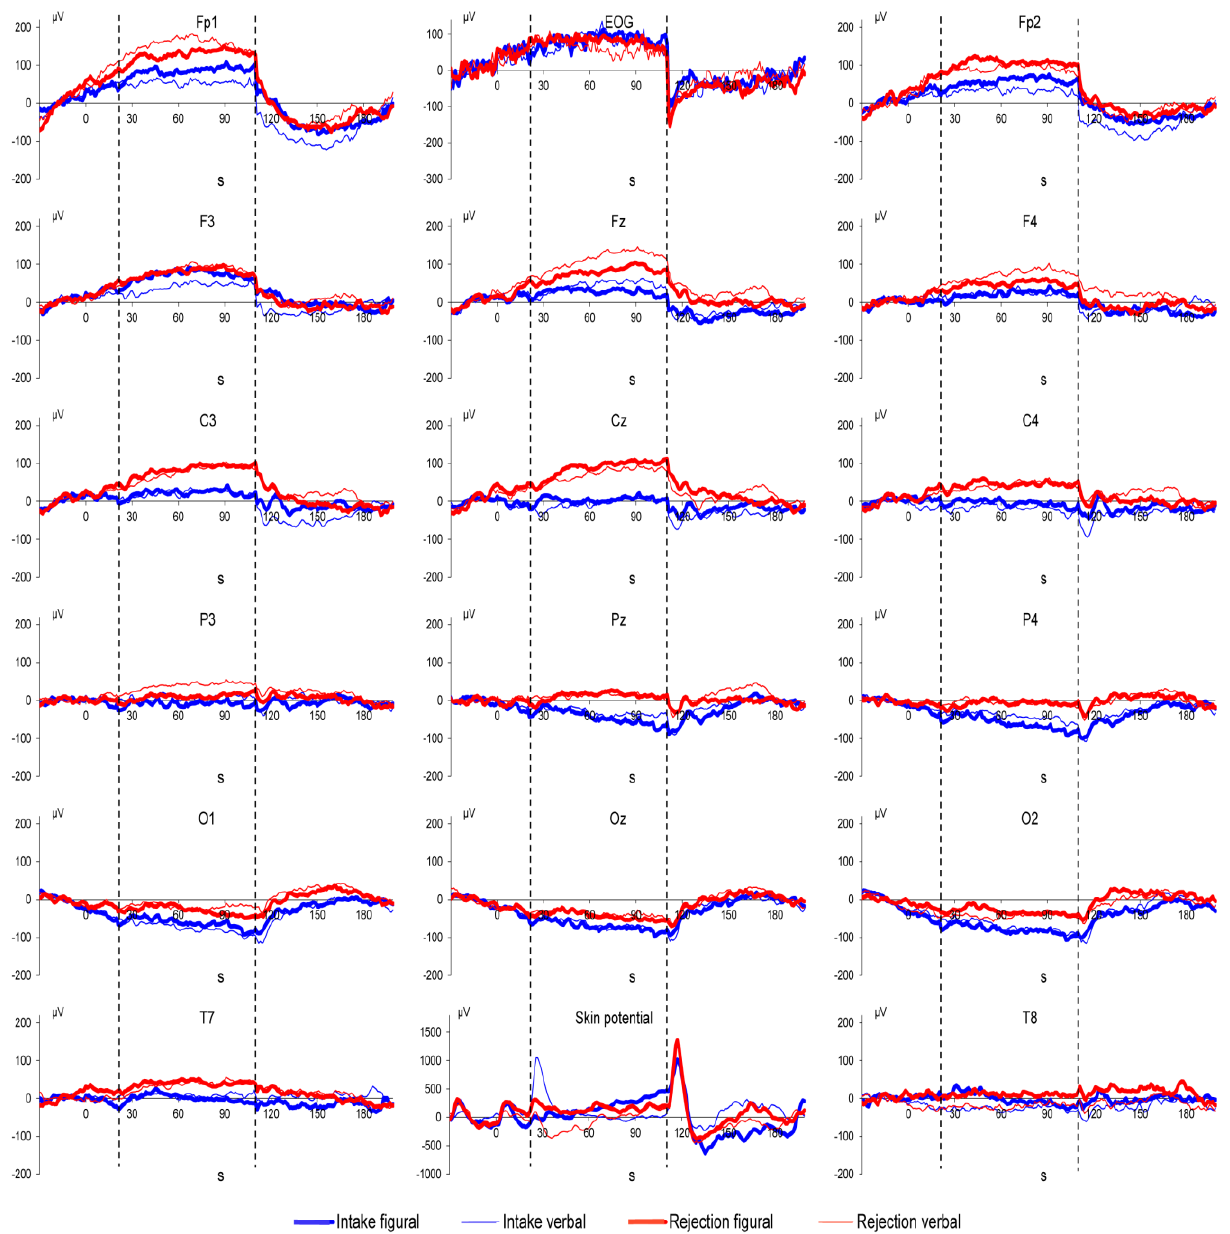
Figure 1. No-noise condition: Grand means of brain DC potentials (positivity upward) as well as vertical EOG and skin potential for the four attention task conditions. The timeline indicates when instruction (seconds 1–20), attention tasks (seconds 21–110; between the vertical broken lines), and examination of task execution (seconds 111–200) took